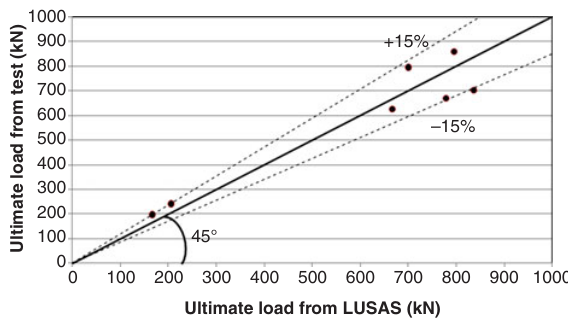
Fig. 3. Comparison between FE results and test